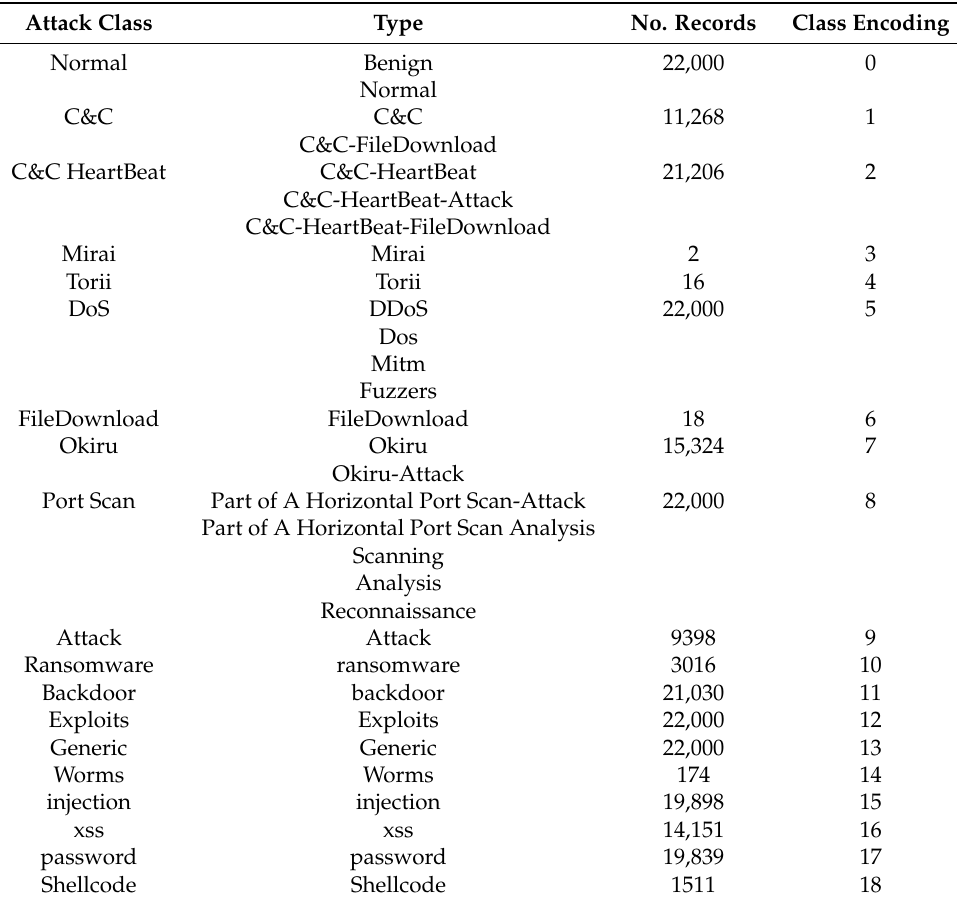
Table 3. Attack classes and type.